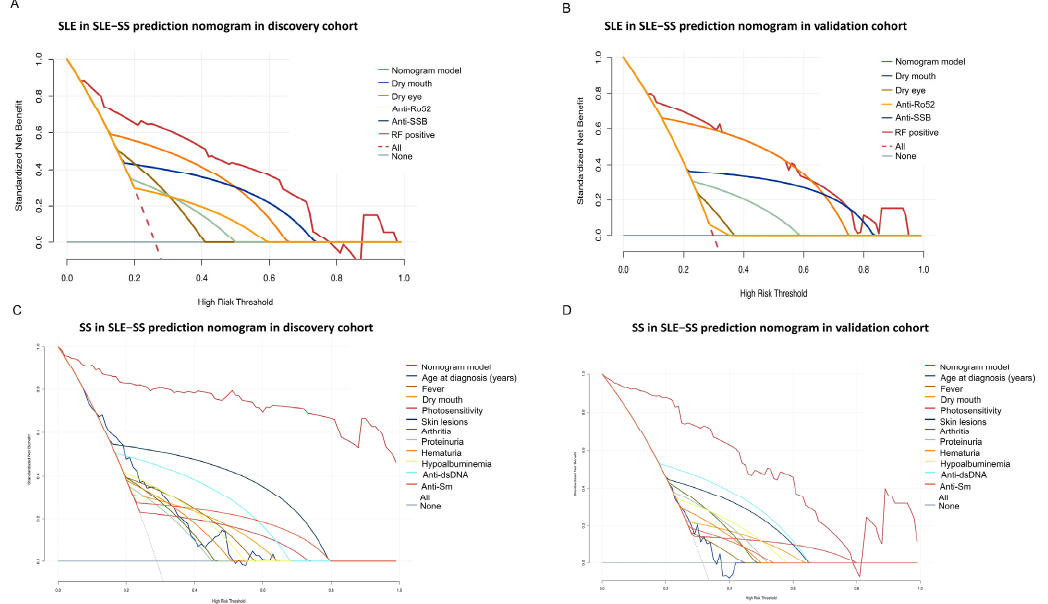
Figure 5. The SLE in the SLE-SS decision curves analysis in the discovery cohort ( A ) and validation cohort ( B ) assessed the clinical usefulness of the prediction model and other indicators. The SS in the SLE-SS decision curves analysis in the discovery cohort ( C ) and validation cohort ( D ) assessed the clinical usefulness of the prediction model and other indicators.